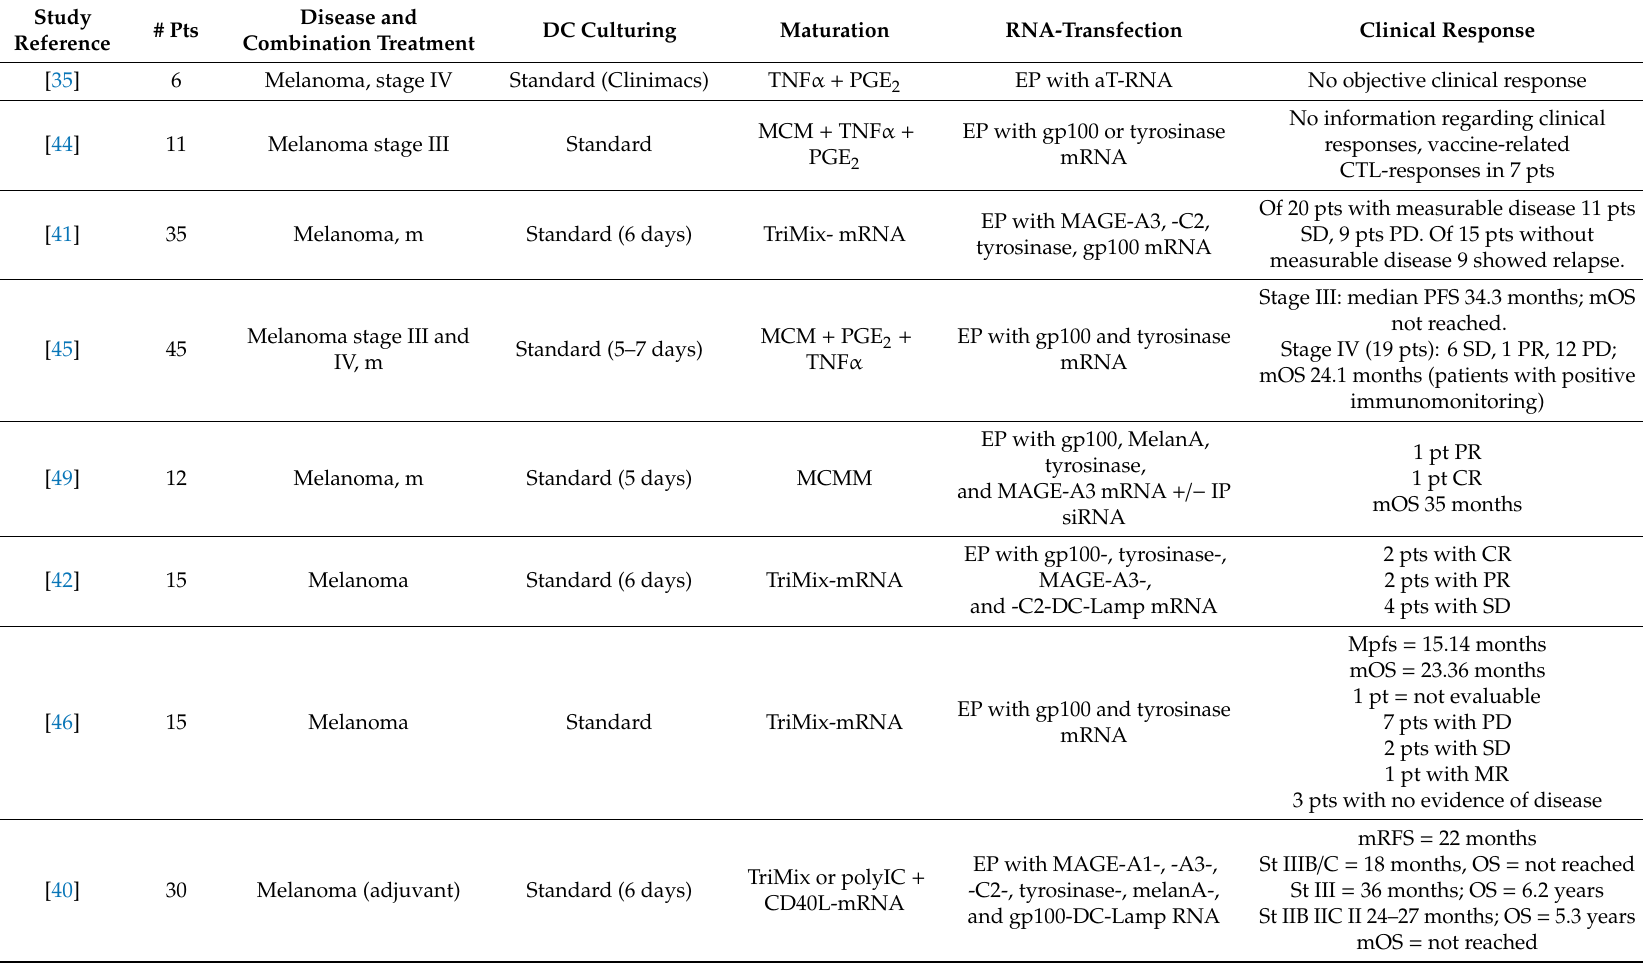
Table 2. Clinical e ffi cacy of RNA-based DC